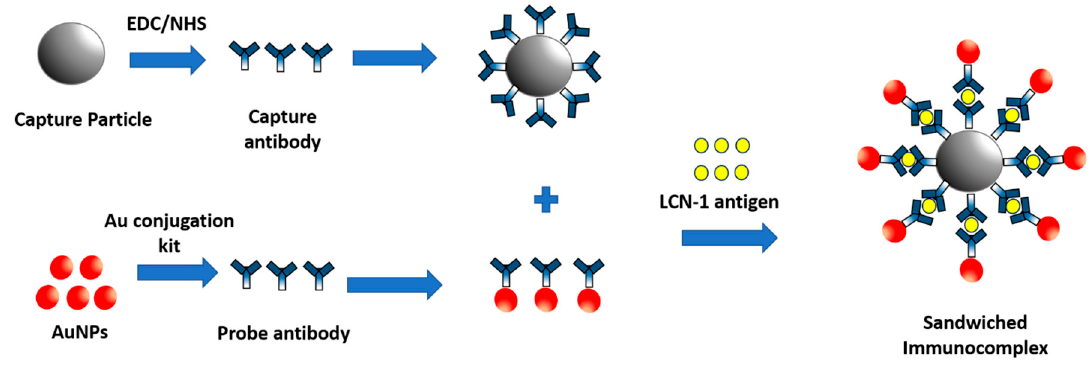
Figure 3. Illustrations for preparing sandwiched immunocomplex and detection